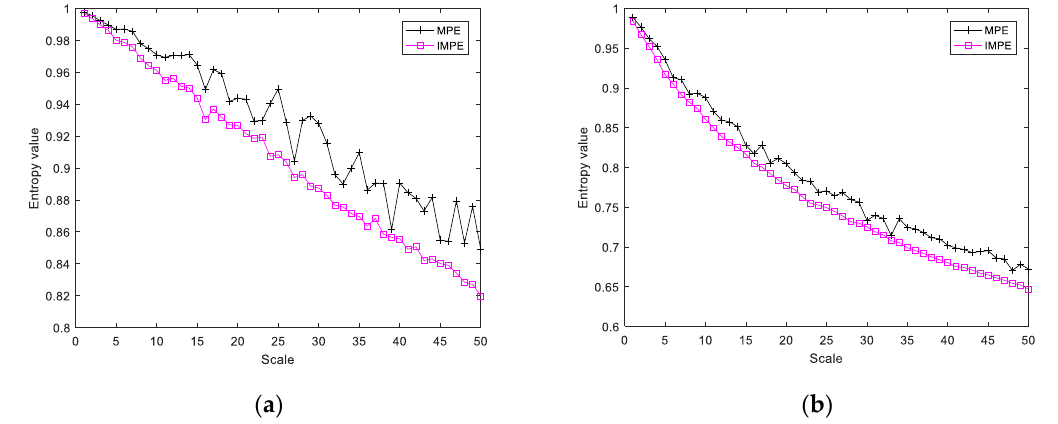
Figure 2. Distribution of MPE and IMPE of WGN: ( a ) m = 6; ( b ) m = 7. To further demonstrate the advantages of the IMPE, different WGN with 500, 1000, 3000, and 5000 sampling points were analyzed 100 times. The standard deviation index was used to evaluate the stability of MPE and IMPE. The embedding dimension and time delay were set as 7 and 2. Table 1 shows the standard deviations of MPE and IMPE calculated from WGN signals with the scale factor of 1–50. The standard deviations of IMPE under different data lengths are all lower than that of MPE, which means that IMPE can improve the stability of MPE. Table 1. The standard deviations of MPE and IMPE calculated from WGN .